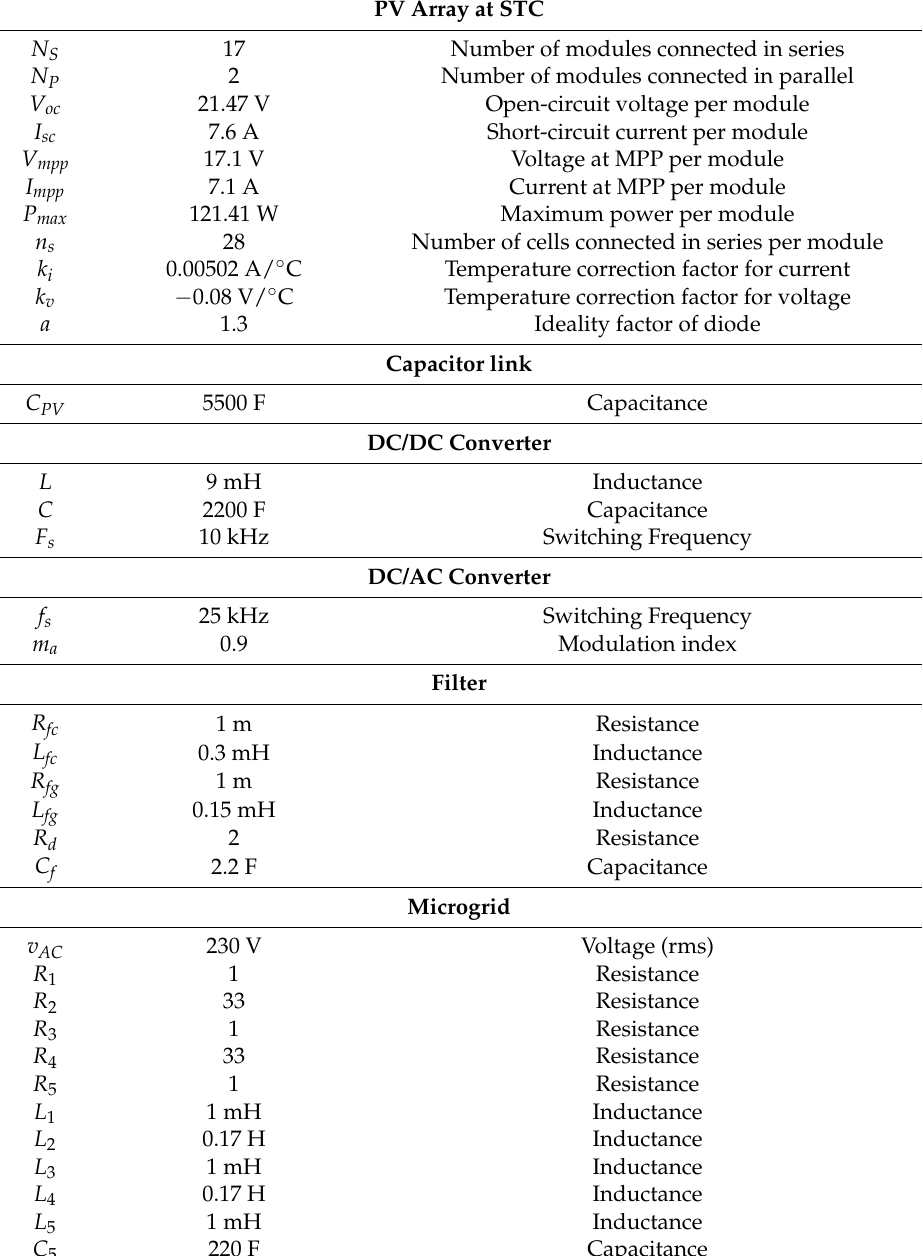
Table 1. Data of grid-connected PV generation